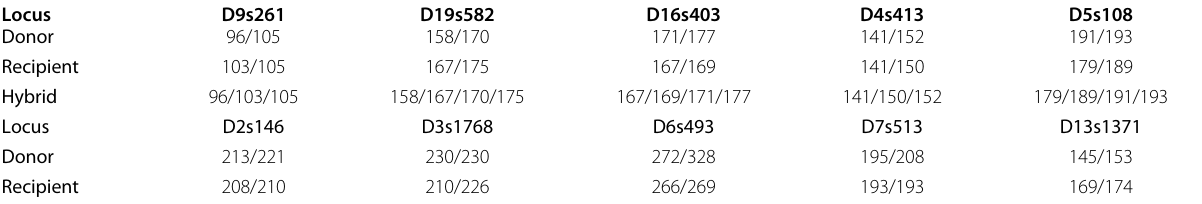
Table 1 Microsatellite analysis of monkey hybrid stem cells Locus